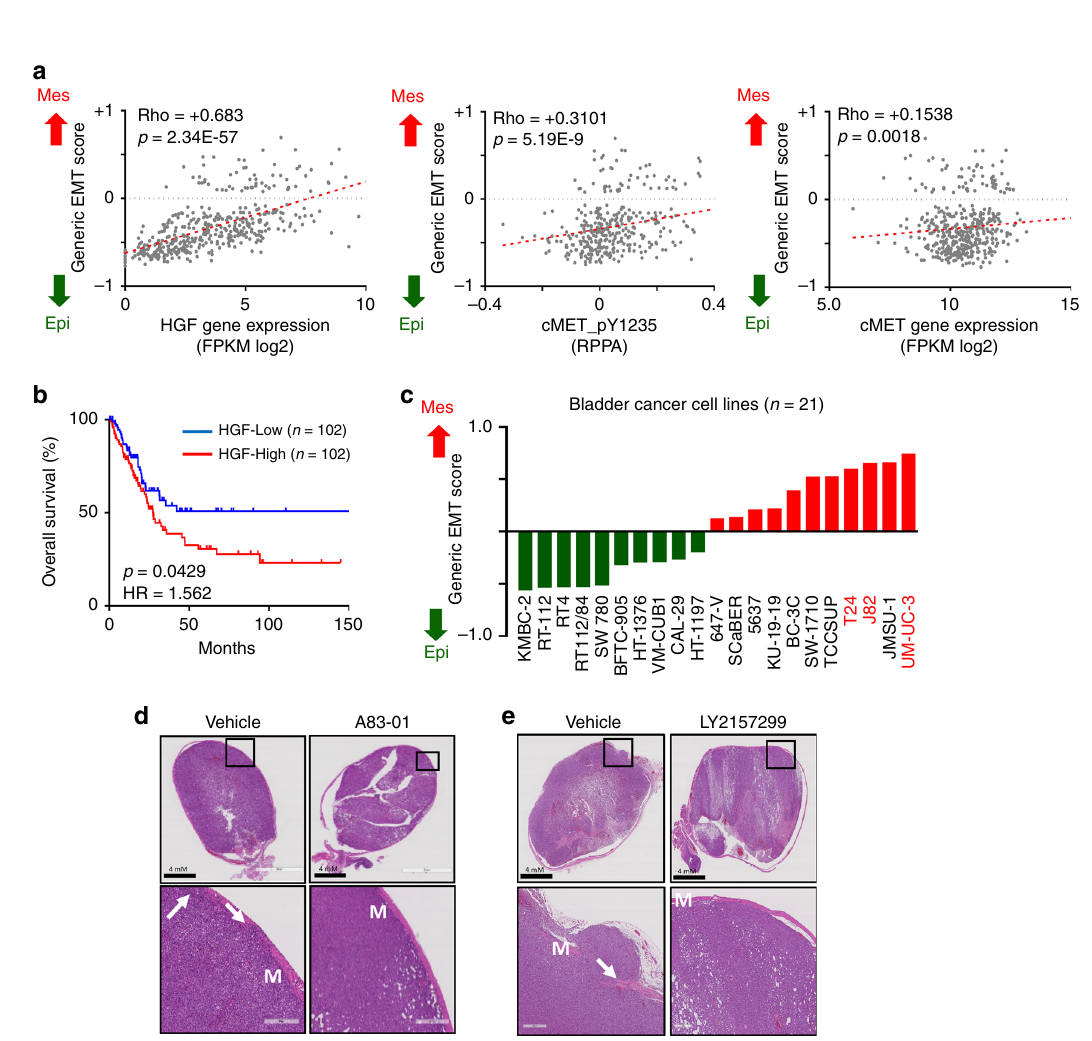
Fig. 7 HGF-induced invasion is abrogated by T β R inhibition. a EMT scores of TCGA Bladder Cancer data set (BLCA n = 408) compared with HGF expression (left panel; R = 0.683, p = 2.3E-57), phospho c-Met expression (middle panel; R = 0.3101, p = 5.19E-9) and c-Met expression (right panel; R = 0.1538, p = 0.0018). The p value is computed by Spearman correlation coef fi cient test. b Kaplan – Meier curves showing probability of overall survival of bladder cancer patients with higher copy number of HGF is signi fi cantly less than those with lower level of HGF (BLCA n = 408, p = 0.0429, HR = 1.562). The p value is computed by log-rank test. c EMT scores of 21 bladder cancer cell lines de fi ned as either epithelial (green) or mesenchymal (red). d , e Analysis of bladder tumours formed from intraluminally implanted UMUC3 cells in the absence or presence of T β R inhibitors. Treatment was started when bioluminescence intensity reached ~ 5e 8 photons/sec. Mice were treated for 2 weeks and tumour volumes were measured twice a week. M = muscularis propria. d H&E staining of representative tumour samples. Daily administration of vehicle control only (control; n = 5) or A83-01 (50 mg/kg; n = 5). T-stages at end of experiment in control-treated mice indicated T3-3 mice, T2-2 mice. All A83-01 treated mice were T1. Scale bars: 4 mm. e H&E staining of representative tumour samples. Daily administration of vehicle control only (control; n = 3) or LY2157299 (80 mg/kg; n = 3). T-stages at end of experiment indicated T3-1 mice, T1-2 mice. All LY2157299 treated mice were T1. Scale bars: 50